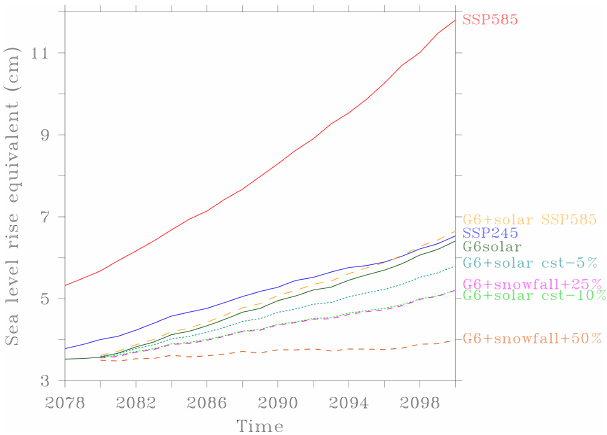
Figure 2. (a) Time series of the cumulative SMB anomalies from 2015 (gauged here in sea level rise equivalent) as simulated by the three main scenarios as well by the G6solar-based sensitivity exper- iments (G6solar with the solar constant from SSP585, G6solar with an artificial increase in snowfall and G6solar with an artificial de- crease in solar constant) starting in 2080. The three reference runs are displayed as solid lines and the four sensitivity experiments as dashed or dotted lines. Finally, the same figure but starting in 2010 is provided in the Supplement (see Fig.